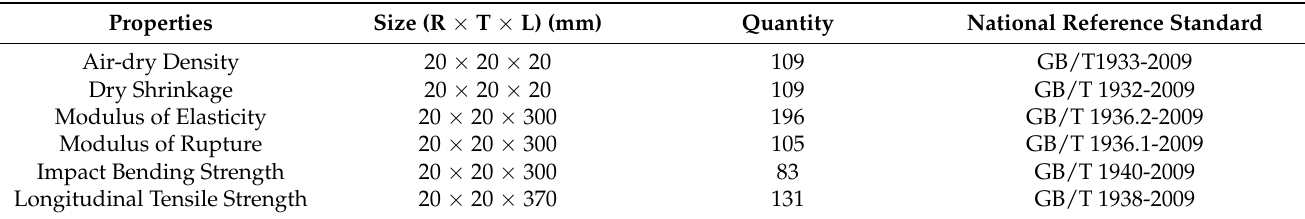
Table 1. Specimen sizes, quantities and the national Chinese reference standards used in their